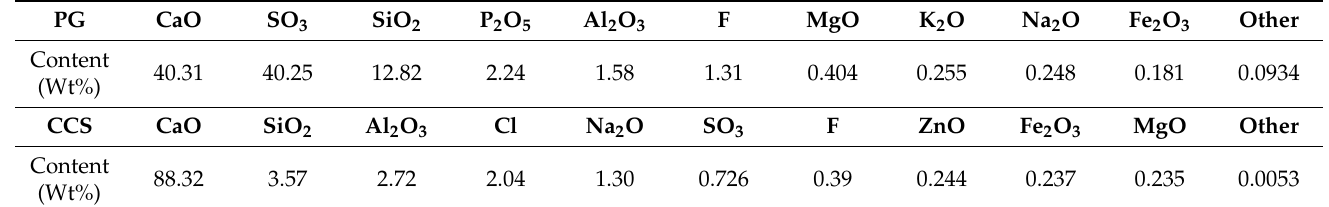
Table 3. Analysis of XRD of PG and